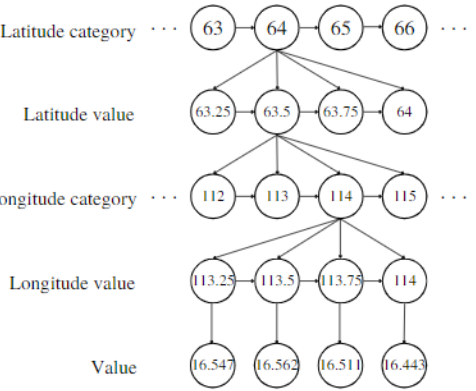
Figure 5. Example of created latitude and longitude tree